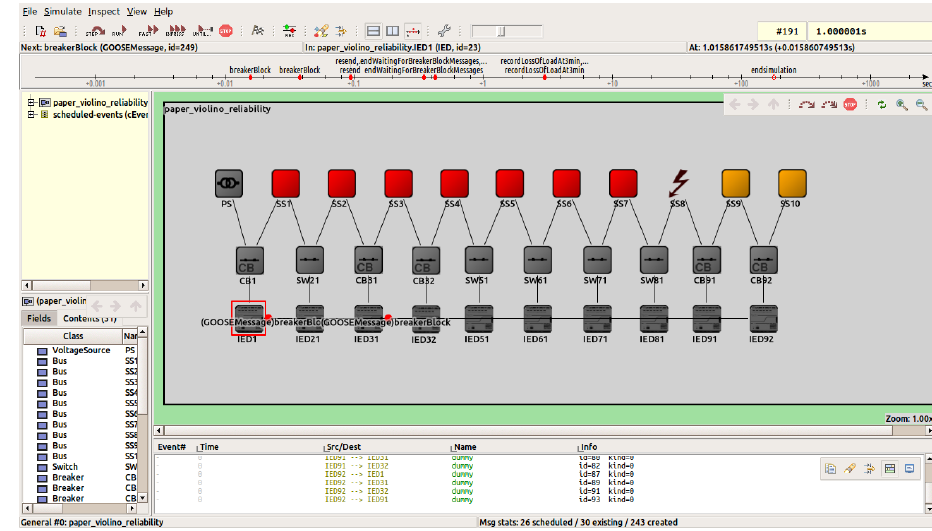
Figure 1. OMNeT++ visual interface containing one of the simulated